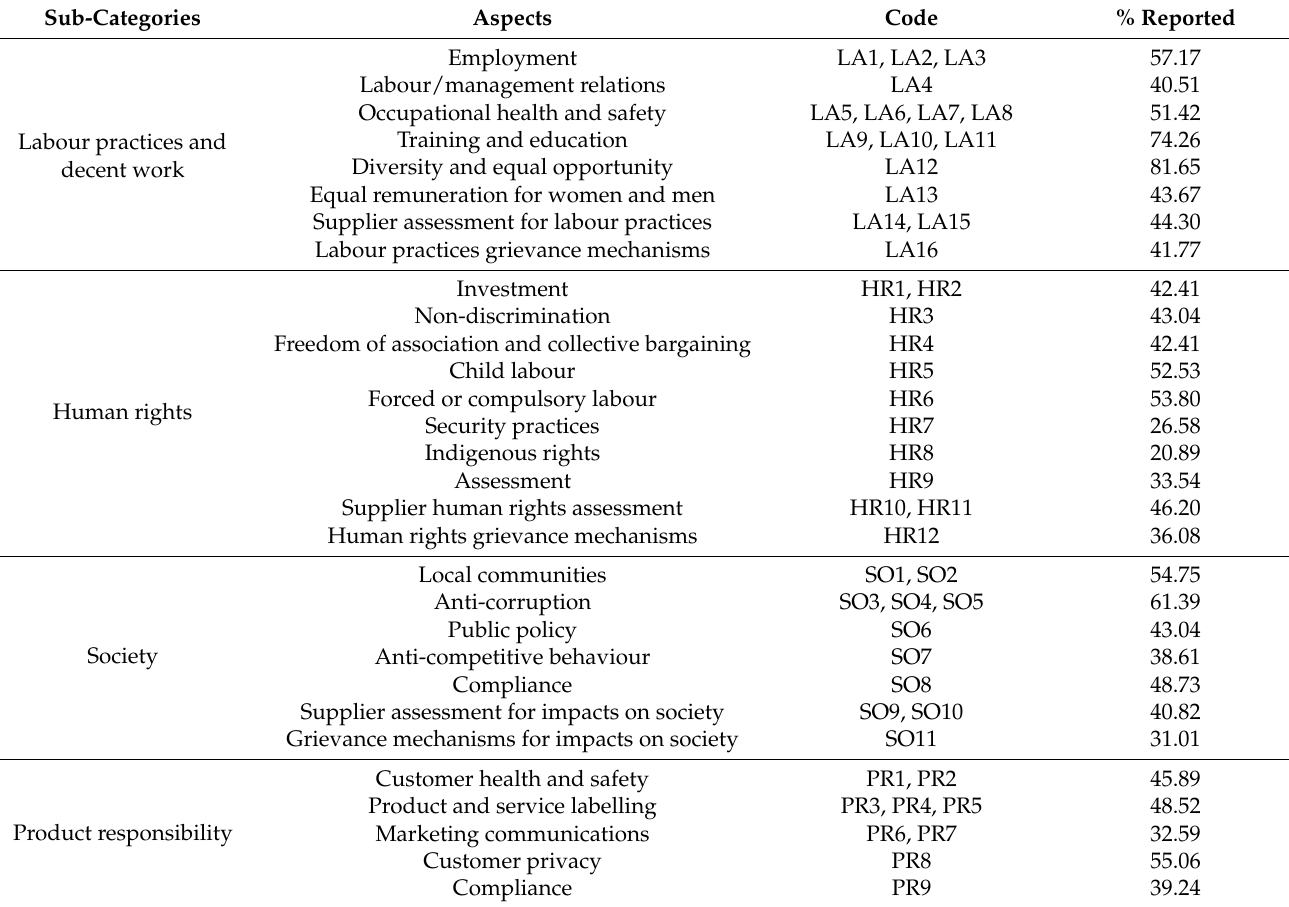
Table 2. Descriptive statistics of social